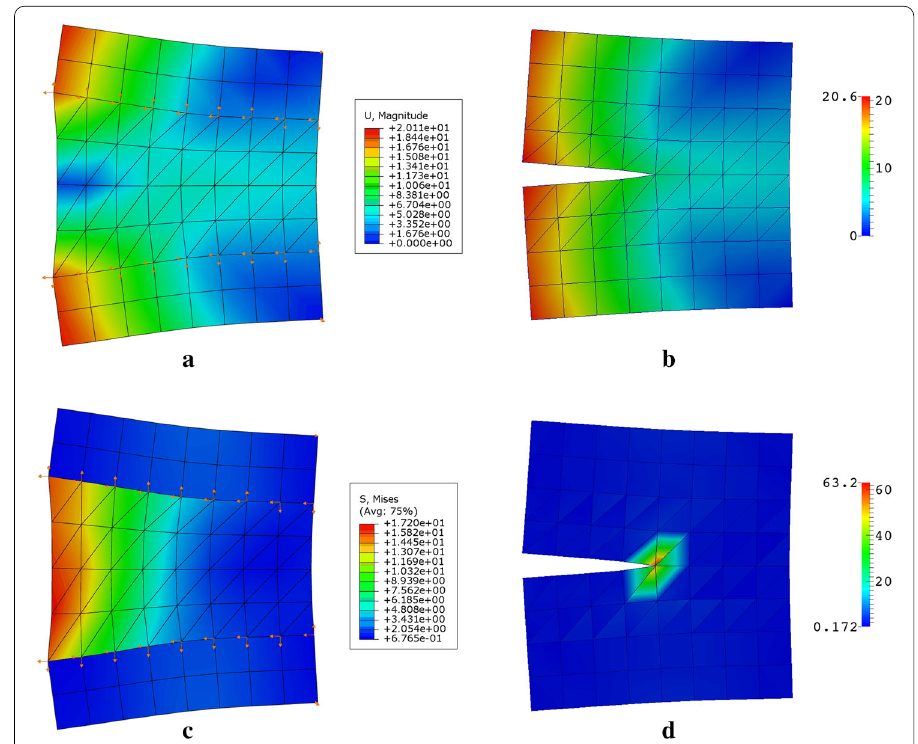
Fig. 8 Visualizations for Abaqus-ISET results— a Displacement post-processed by Abaqus— b displacement post-processed by ISET— c von Mises stress post-processed by Abaqus— d von Mises stress post-processed by ISET. This figure presents Abaqus-ISET results on a mesh with elements available only in Abaqus. Post-processing over those elements must be done by Abaqus while over elements enriched with crack tip functions it must be done by